Question: What form of chart is displayed?
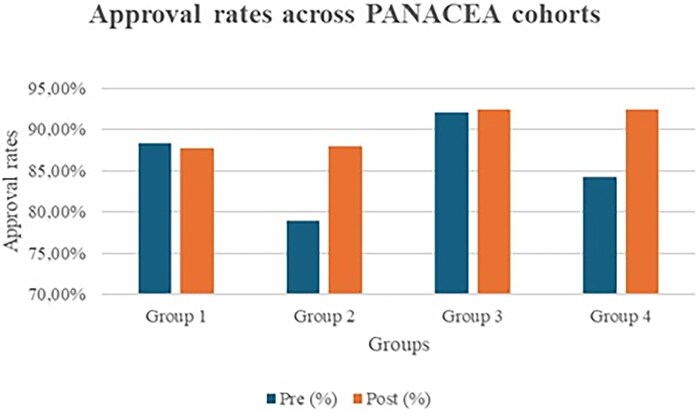
Answer: bar